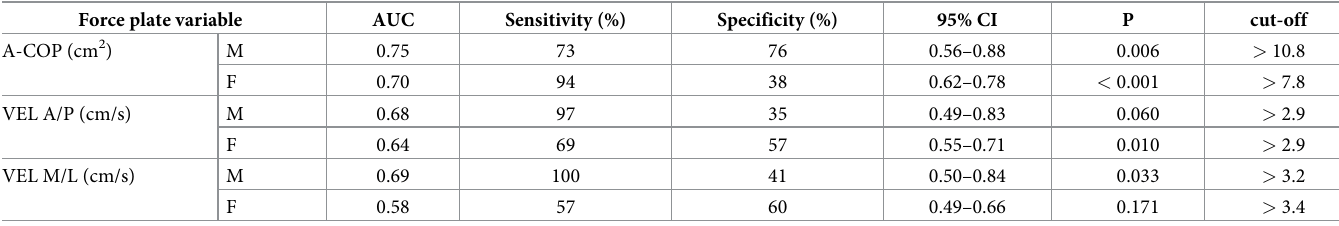
Table 3. Area under curve, sensitivity, specificity for the force platform variables separated for sex (n = 32 male and 138 female). Force plate